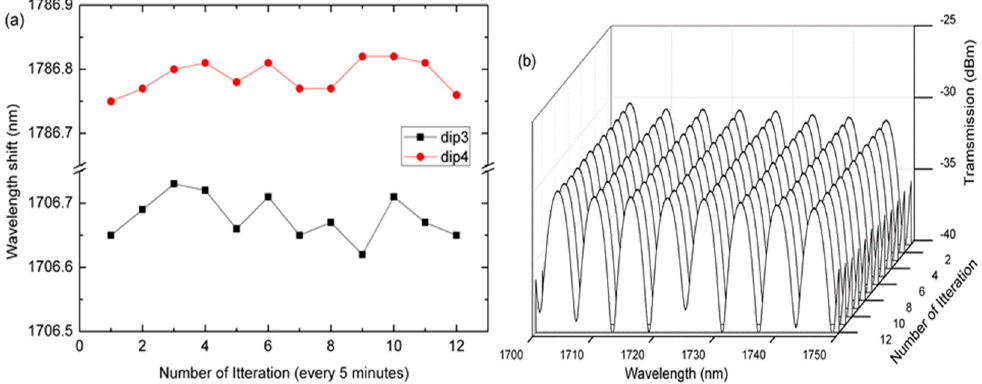
Figure 7. ( a ) Stability of the MFI at dip3 and dip4 immersed in 20 ppm ammonia nitrogen for 1 h. ( b ) The stability of the MFI transmission spectrum for 1 h immersed in 20 ppm ammonia-nitrogen.